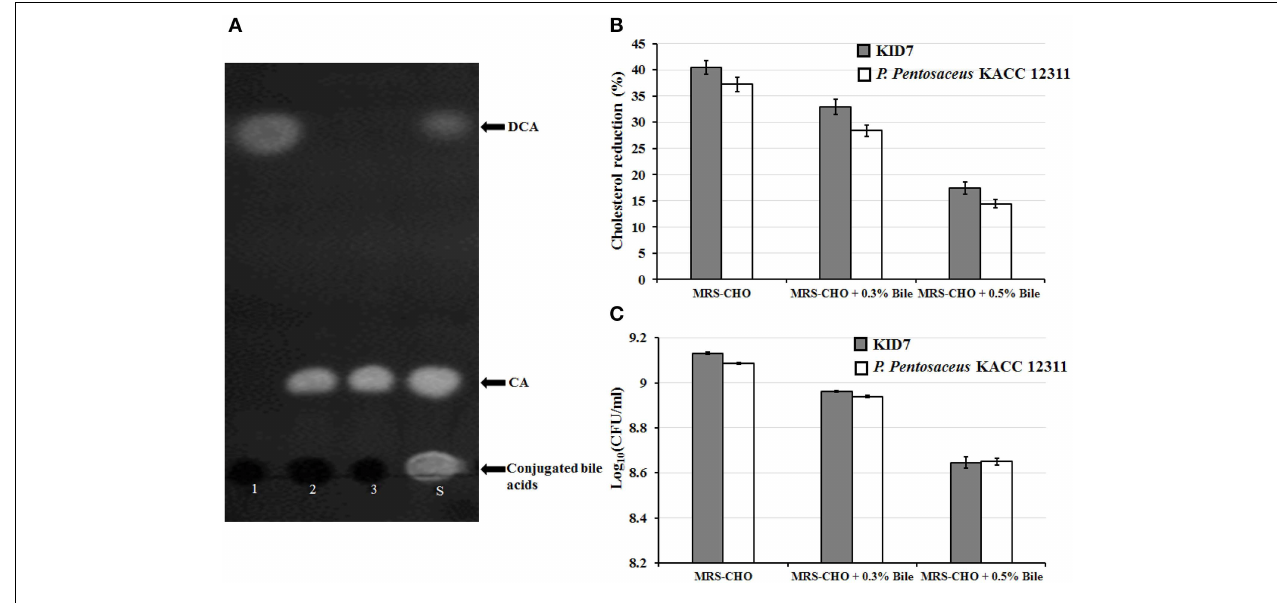
FIGURE 3 | In vitro cholesterol-lowering activity of P. pentosaceus KID7. (A) Thin-layer chromatography analysis of free cholic acid present in the culture filtrate of KID7 grown in MRS containing various conjugated bile salts. 1, MRS + 5mM TDCA; 2, MRS + 5mM TCA; 3, MRS + 5mM GCA; S, Standard mixture of TDCA, TCA, GCA, cholic acid (CA), and deoxycholic acid